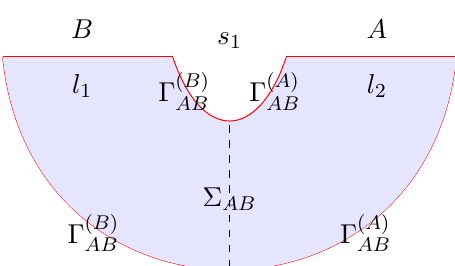
Figure 1 . Pictorial representation for E W ( A : B ) . The region in the blue color is the entanglement wedge M . The boundary of the wedge (the red curve) is obtained as the union of A , B , Γ ( A ) AB and Γ ( B ) . The dashed curve represents Σ AB